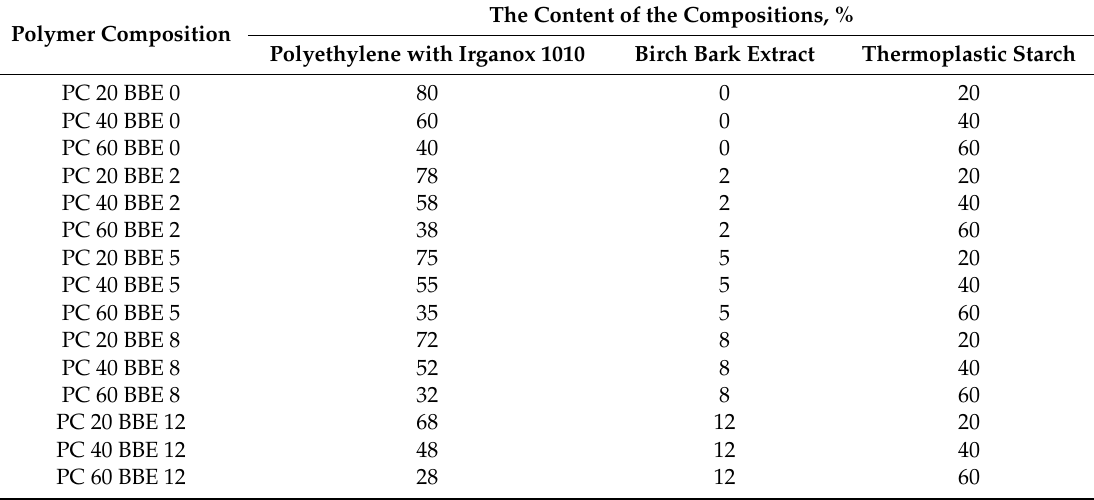
Table 4. The component composition of the polymeric compositions based on polyethylene (PE) with birch bark extract (BBE) and thermoplastic